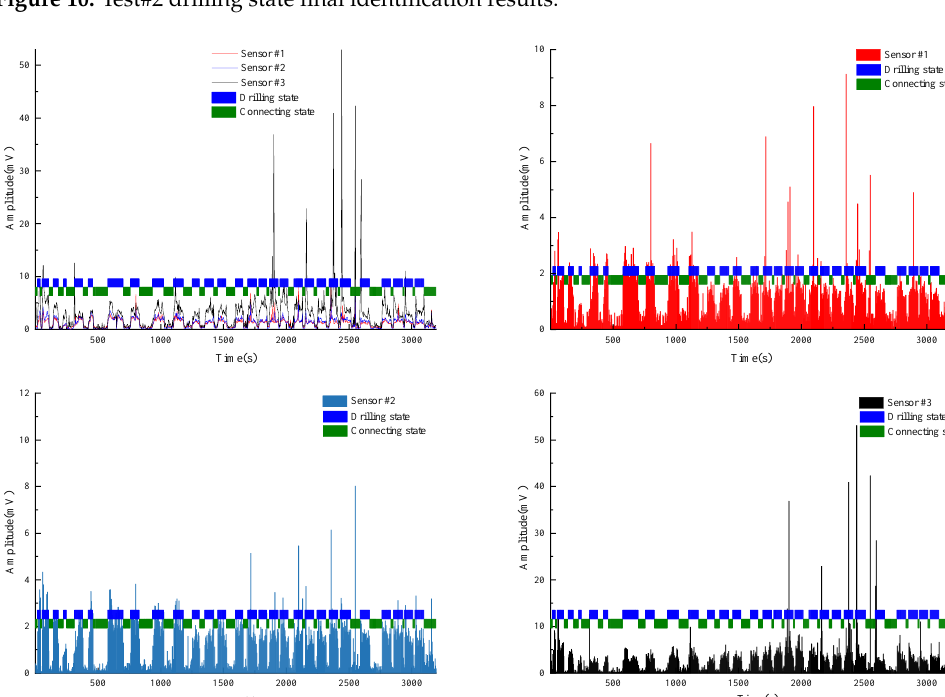
Figure 11. Test#3 drilling state final identification results.